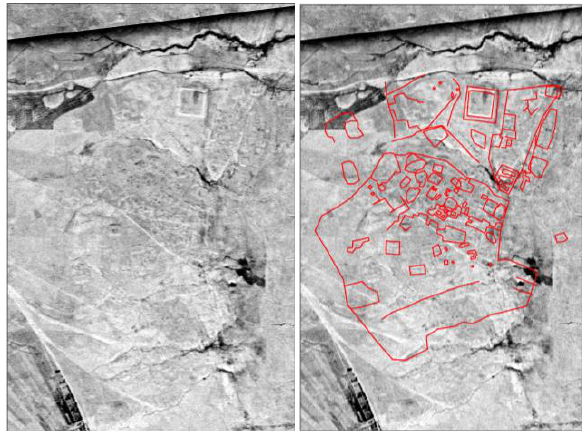
16.8. 1968) with an overlaid objects of interest on the right